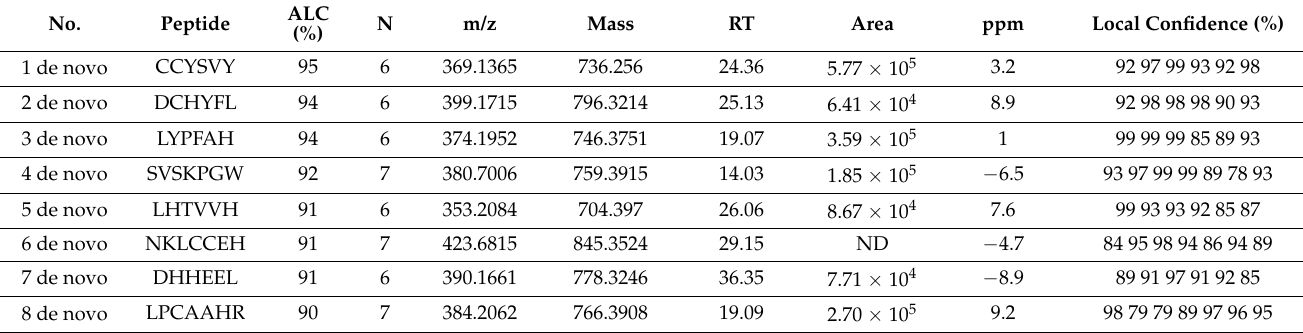
Table 3. Endogenous peptides identified in virgin olive oil by de novo sequencing: ALC, average local confidence; N, number of amino acids; m/z, precursor mass-to-charge ratio; mass, peptide mass in Da; RT, retention time; area, peptide abundance shown as area under the curve of the detected peptide; ppm, precursor mass error; local confidence, local confidence score for each amino acid of the peptide identified by de novo sequencing. Oxidised methionine is indicated by a pair of parentheses enclosing the modification mass (+15.99). ND, not detected.